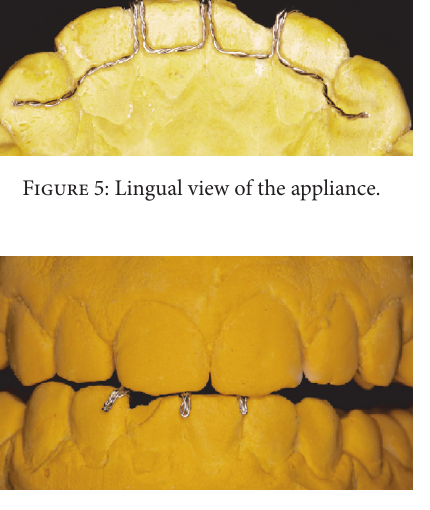
Figure 6: Buccal view of the appliance showing the eventual deliberate interference with the nail biting contact position of the patient.